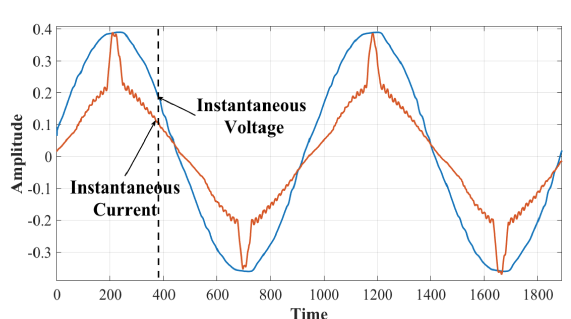
Figure 1. Instantaneous voltage and current